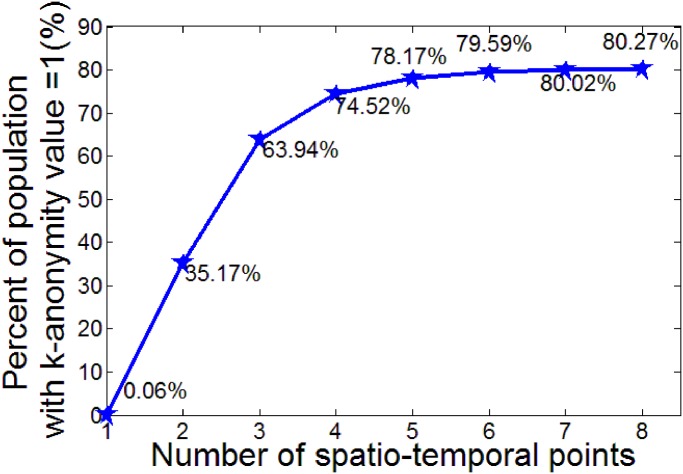
Population with 100% re-identification risk under different number of spatio-temporal points.